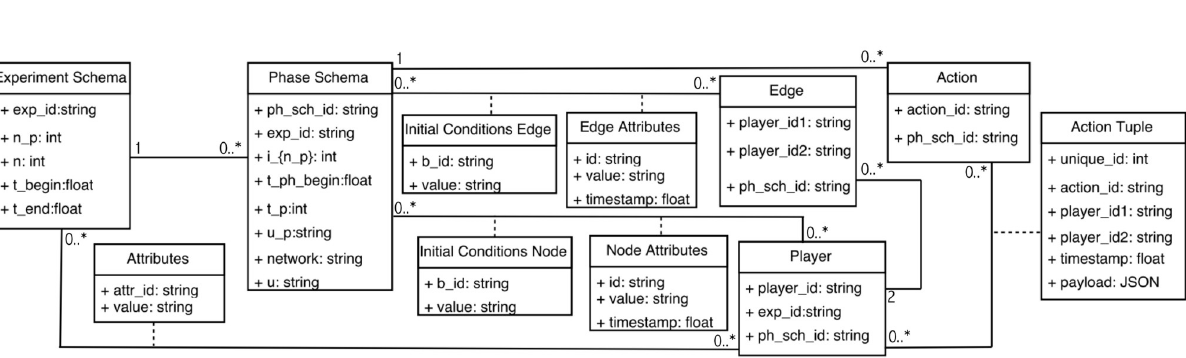
PLOS ONE | https://doi.org/10.1371/journal.pone.0242453 November24,